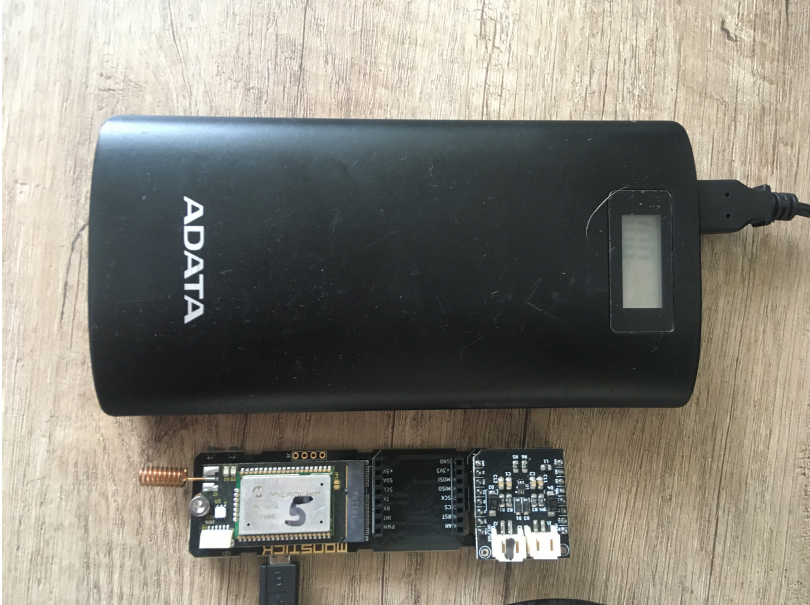
Figure 11. Mobile measuring system composed of modular sensor and power